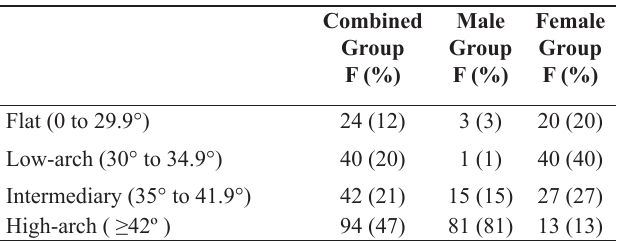
Table 2. Descriptive analysis of the plantar arches characteristics.